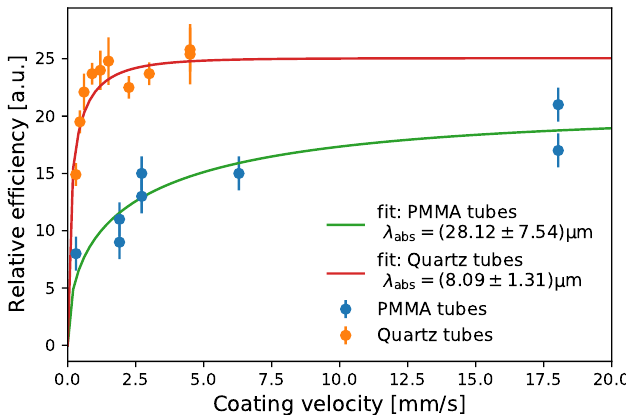
Figure 9. One-sided efficiency at 375nm versus the coating speed for quartz tubes and PMMA tubes. Efficiencies are read out by a PMT 150mm away from the illumination point. The solid lines show a fit with the thickness and absorption model from Equations (7) and